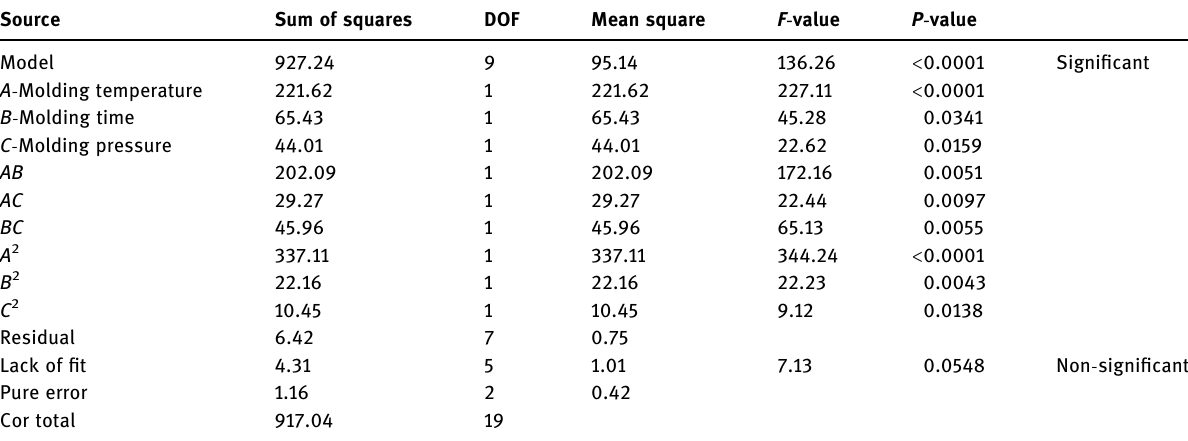
Table 7: ANOVA for tensile strength